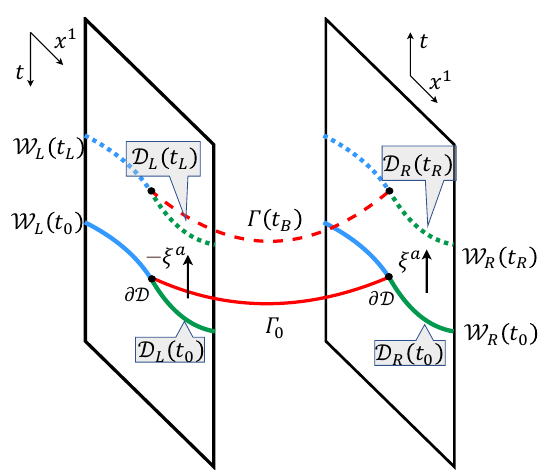
Figure 1 . The sketch of boundary CFT time slice and extremal surface. The two boundary slices W R and W L combine into the total system W . D is the subsystem of W , which marked in green. The blue parts are the complement subsystem of D . The extremal surface Γ 0 anchors on the subsystem boundaries ∂ D , which marked in red. ξ a and − ξ a are Killing vectors on the right and left